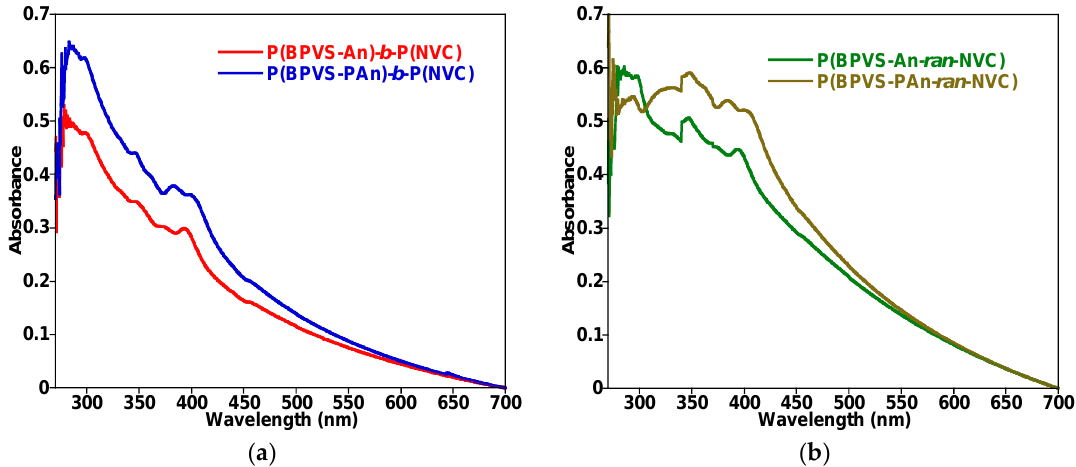
Figure 2. UV-vis absorption spectra of ( a ) block copolymers and ( b ) random copolymers in solid thin films. The sample was prepared by spin-coating from THF solution (10 mg/mL).